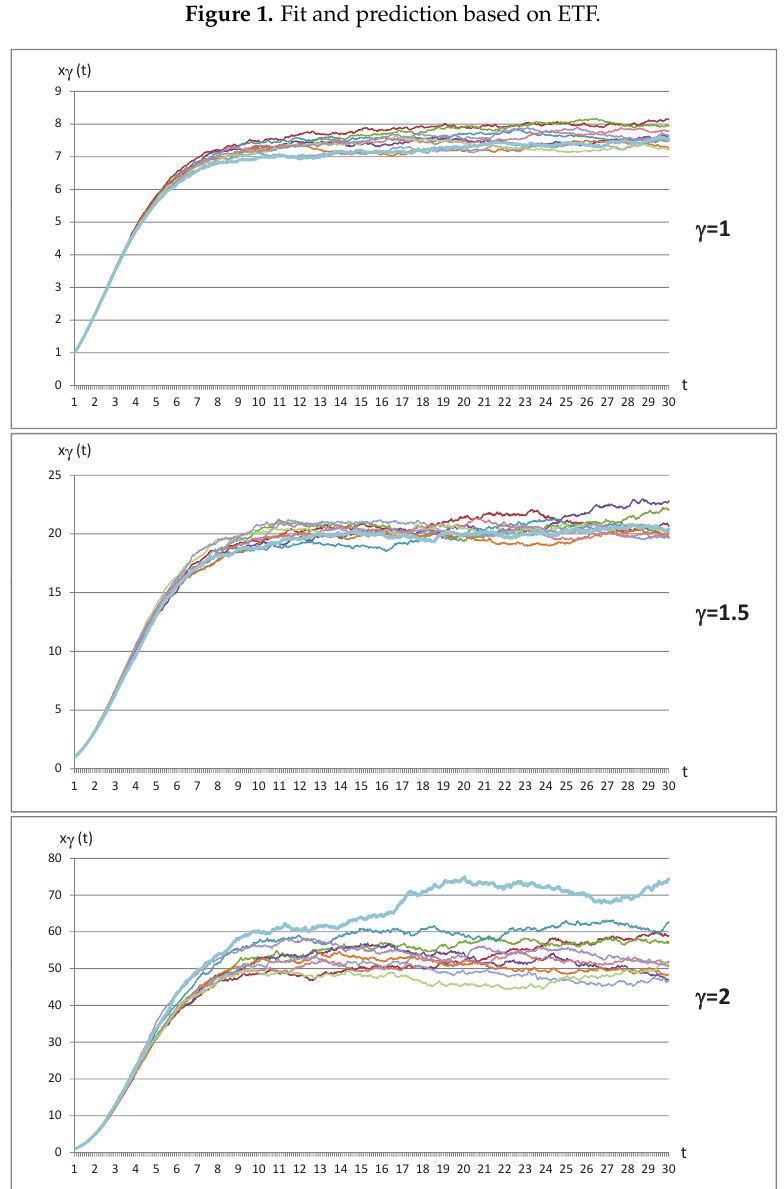
Figure 2. Fit and prediction based on